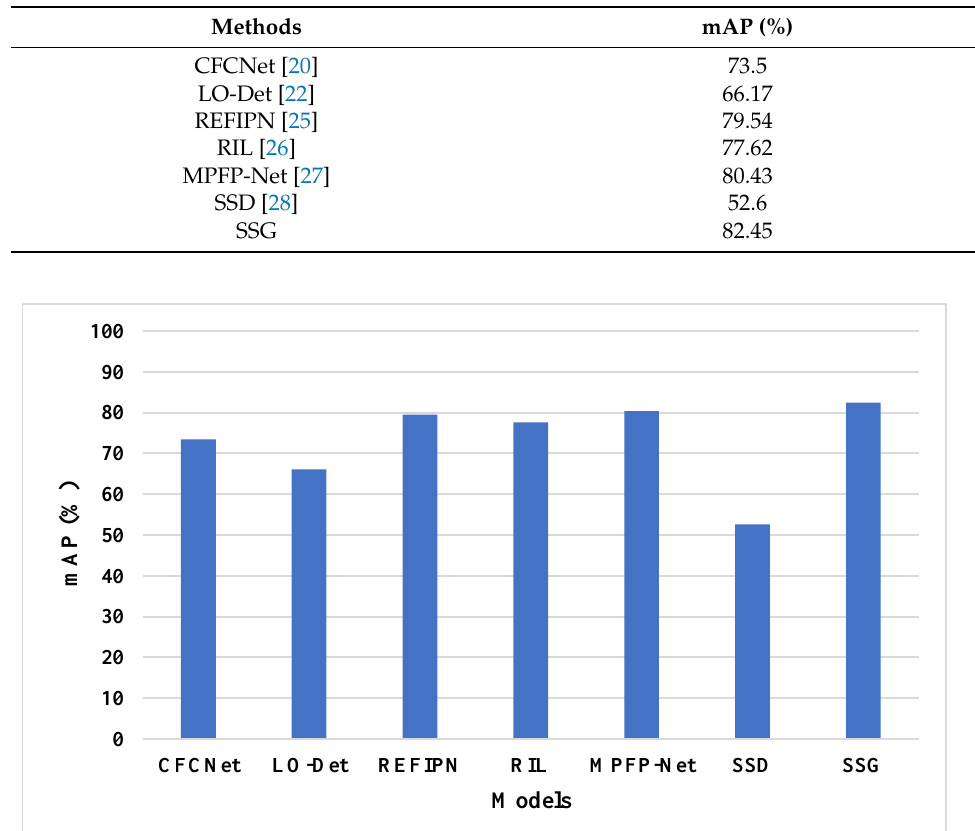
Table 5. Existing model comparison on DOTA dataset.